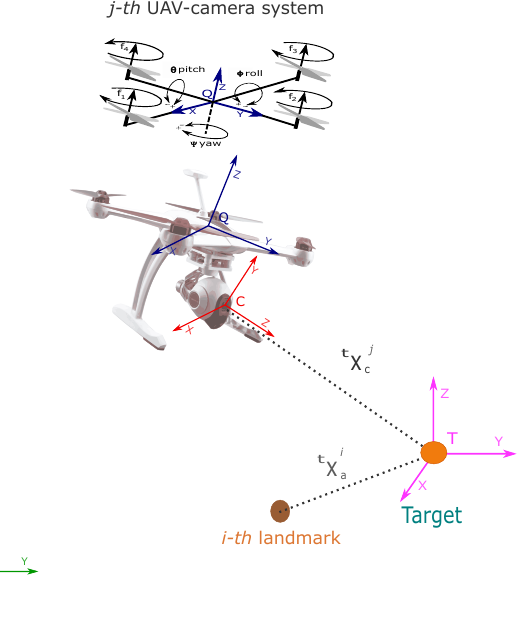
Figure 1. Coordinate reference